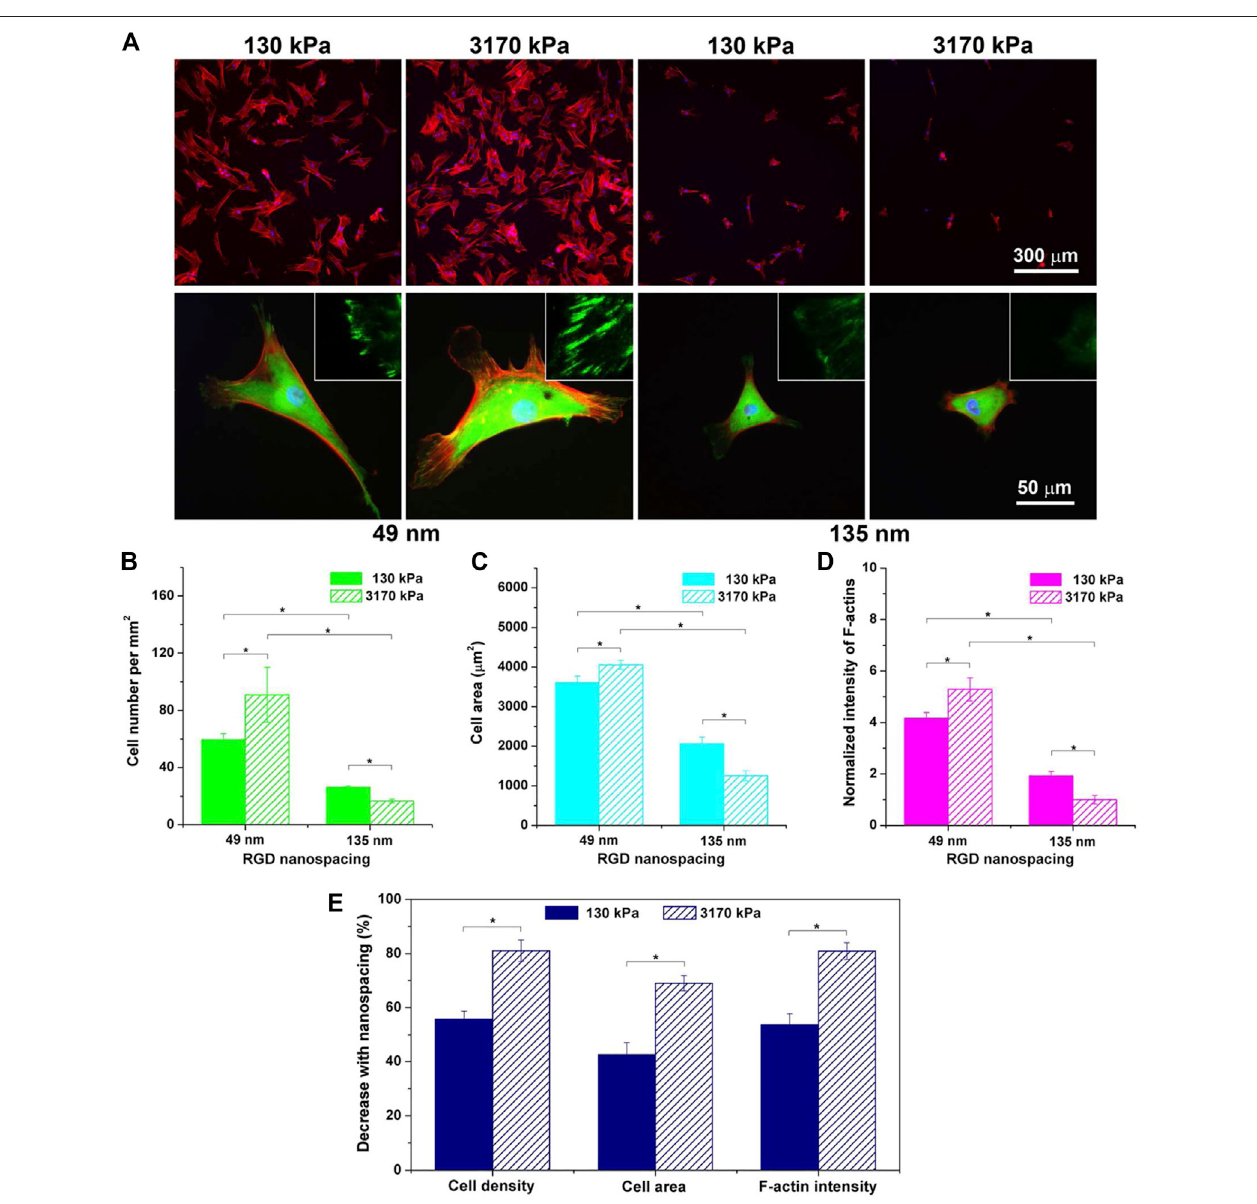
FIGURE 3 | Fluorescence images of cells on RGD-nanopatterned PEG hydrogels and corresponding statistical results as functions of hydrogel stiffness and RGD nanospacing. (A) Cells were cultured on RGD nanopatternsfor 24 h and stained for observations ofvinculins (green), F-actins(red), and nuclei (blue). The upper and the lower rows show typical low-magni fi cation and high-magni fi cation fl uorescence micrographs, respectively. The insets in the lower row demonstrate further magni fi ed local images to show vinculins around theperiphery ofcells. (B – D) Statistical results ofcell density (B) , cell spreading area (C) , and fl uorescent intensity of F-actins normalized to the mean value of the group of the stiff hydrogels (3,170 kPa) with the large RGD nanospacing (135 nm) (D) . Mean values and standard deviations from three independent experiments are presented. (E) Dependence of the indicated parameters upon RGD nanospacing as characterized by the decline percentage at a given matrix stiffness calculated with Eq. 1 ( n = 3 × 3). “ * ” : p < 0.05 in a student ’ s t-test, indicating a signi fi cant difference between the two groups. (Ye et al., 2015). Reprinted (adapted) with permission from (Ye et al., 2015). Copyright (2015 – 2021) American Chemical